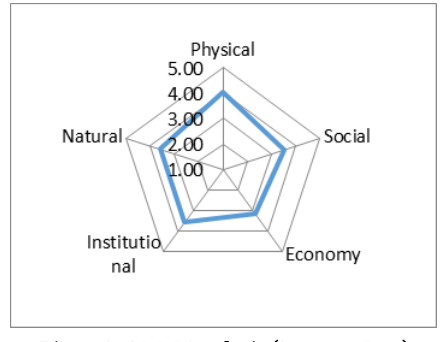
Figure 2: CDRI Analysis (Ampang Jaya)